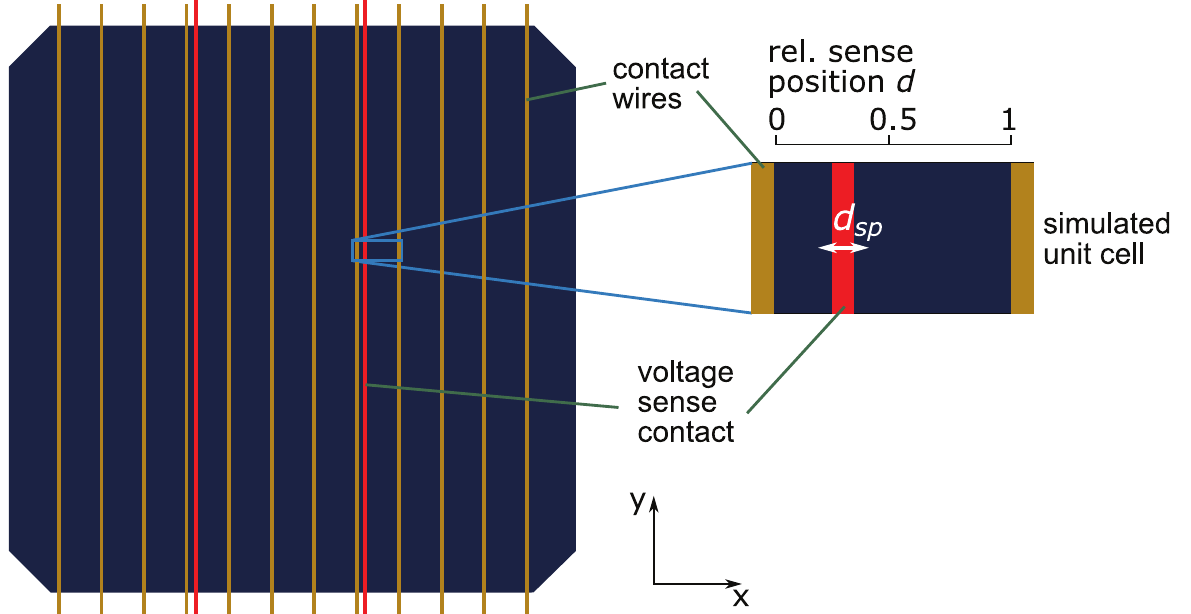
Fig. 2. Schematic top view of measurement setup with 12 current contact wires/bars (orange) including two sensing contacts (red) for precise voltage measurements. The magni fi cation shows the unit cell used for the simulations.